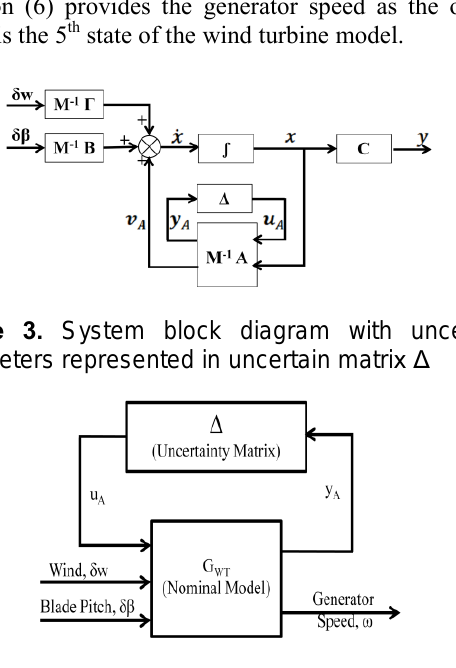
Figure 4. The LFT representation of the perturbed wind